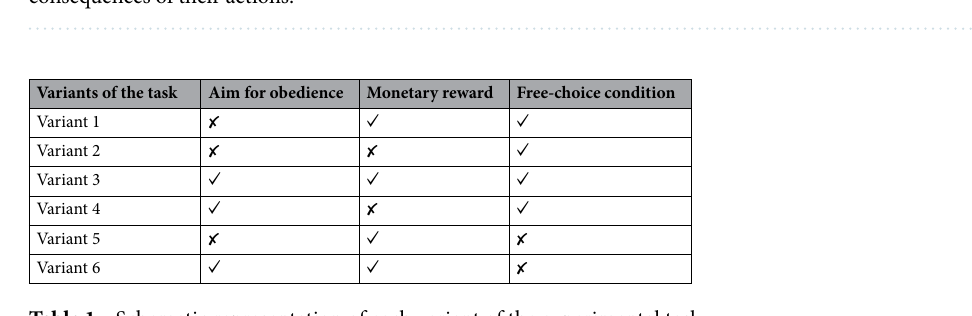
Figure 1. Experimental setup. Schematic representation of the experimental setup. Volunteers were in different rooms. The experimenter was located in a third, separated room. The agent heard on a trial basis the orders of the experiment through headphones and had to decide to press the ‘SHOCK’ or ‘NO SHOCK’ button. A real-time camera feedback displayed the hand of the victim of the agent’s screen so to allow to keep track on the consequences of their actions.